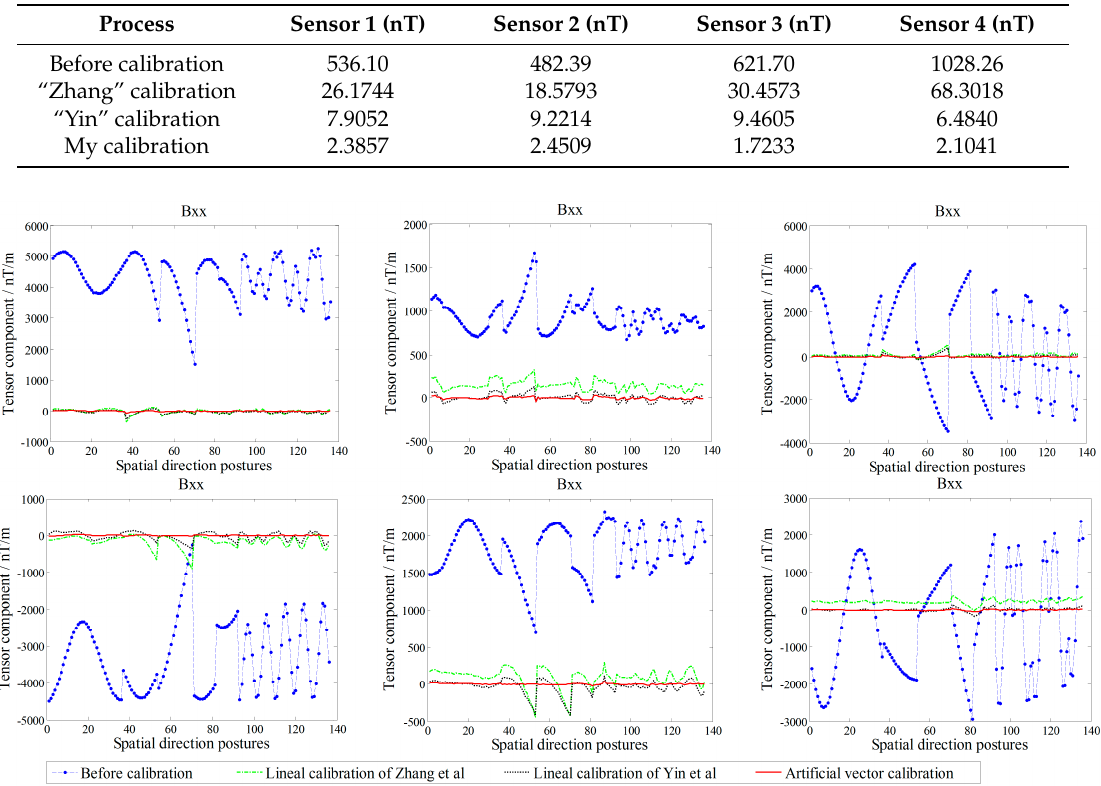
Figure 10. Comparison of tensor components before and after calibration in the experiment.